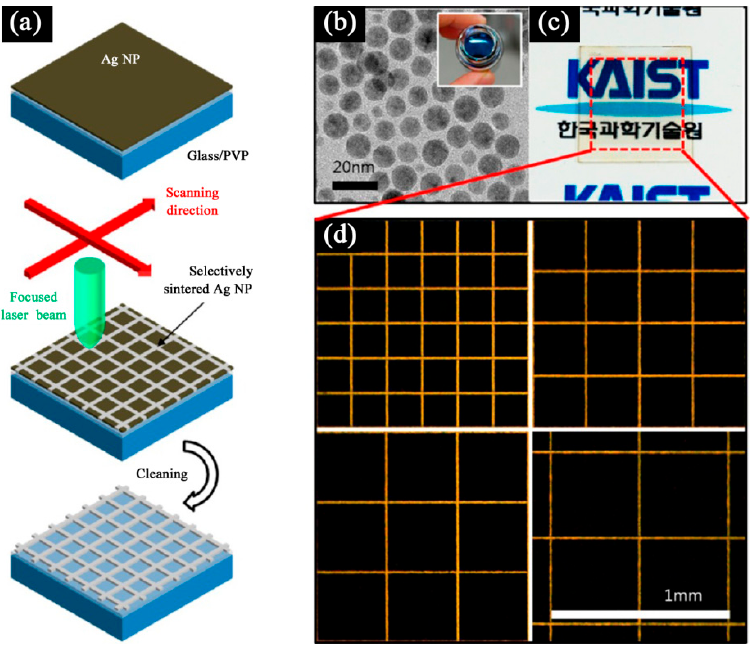
Figure 11. ( a ) schematic diagram of selective laser sintering of Ag NPs for the fabrication of a transparent conductor; ( b ) TEM: Transmission electron microscope (TEM) image of synthesized Ag NPs (inset: optical photograph of Ag NP ink); ( c ) photograph of a transparent conductor on a glass substrate (metallic grid in the red-boxed region); ( d ) optical stereoscope images of square-metallic grids at different grid sizes (200 to 500 μ m, increment 100 μ m). Reproduced with permission from [92]; Copyright 2013 American Chemical Society.